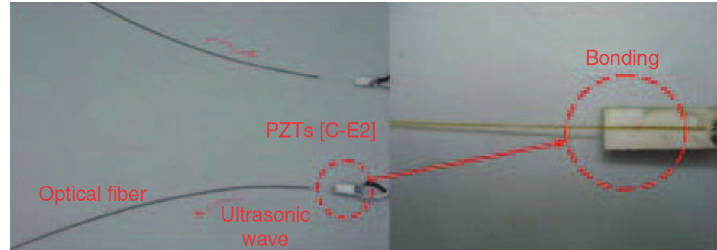
Figure 22: Construction of an ultrasonic active fiber sensor [11].